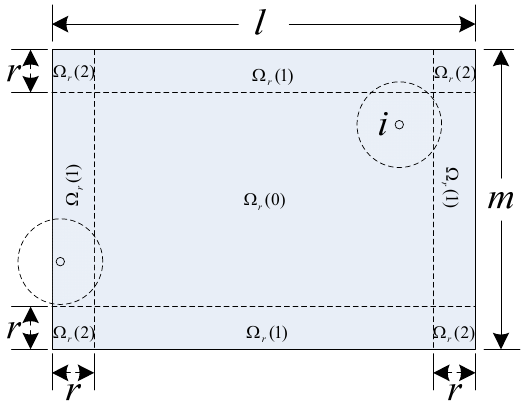
Figure 1. A monitored region and its